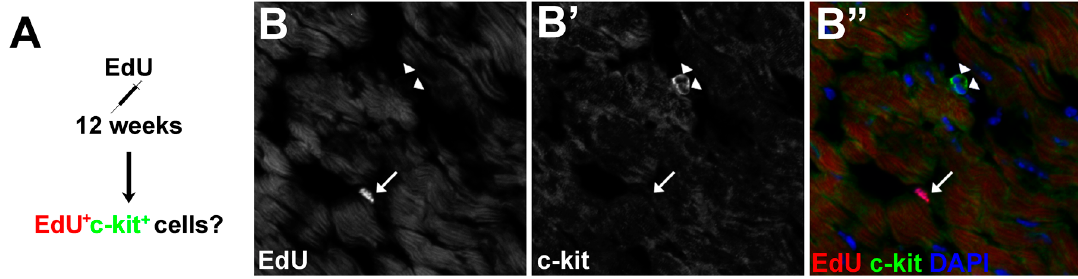
Figure 7. EdU + cells are not c-kit + at 12-weeks of age. ( A ) Wildtype and Asxl2 − / − animals were treated with EdU at 12-weeks of age and frozen sections were assessed for EdU + c-kit + cells; ( B – B” ) Representative image of co-labeling for EdU and c-kit. EdU + c-kit + cells were not observed. Sample size: n = 3 animals per genotype; two non-consecutive sections/heart; ten 20× images/section; 188 wildtype EdU + cells, 265 Asxl2 − / − EdU + cells. Arrows indicate the EdU + nuclei and the arrowheads indicate c-kit + cells.